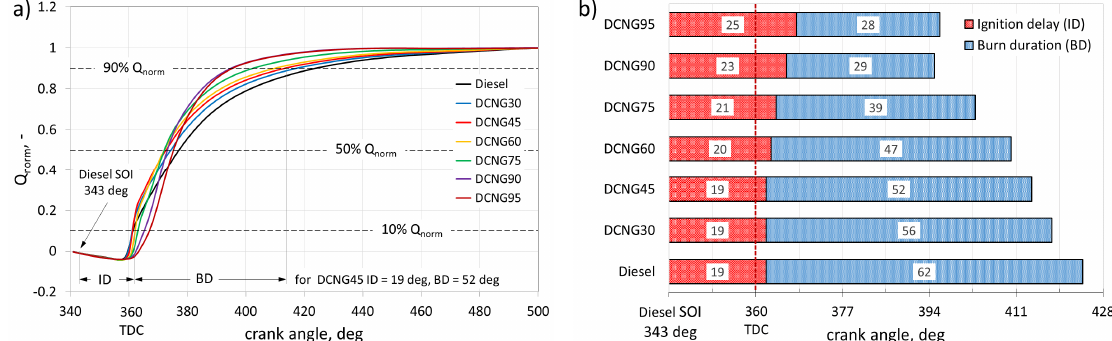
Figure 4. Normalized heat release ( a ) and ignition delay with burn duration ( b ) for analyzed share of CNG gas co-combusted with diesel